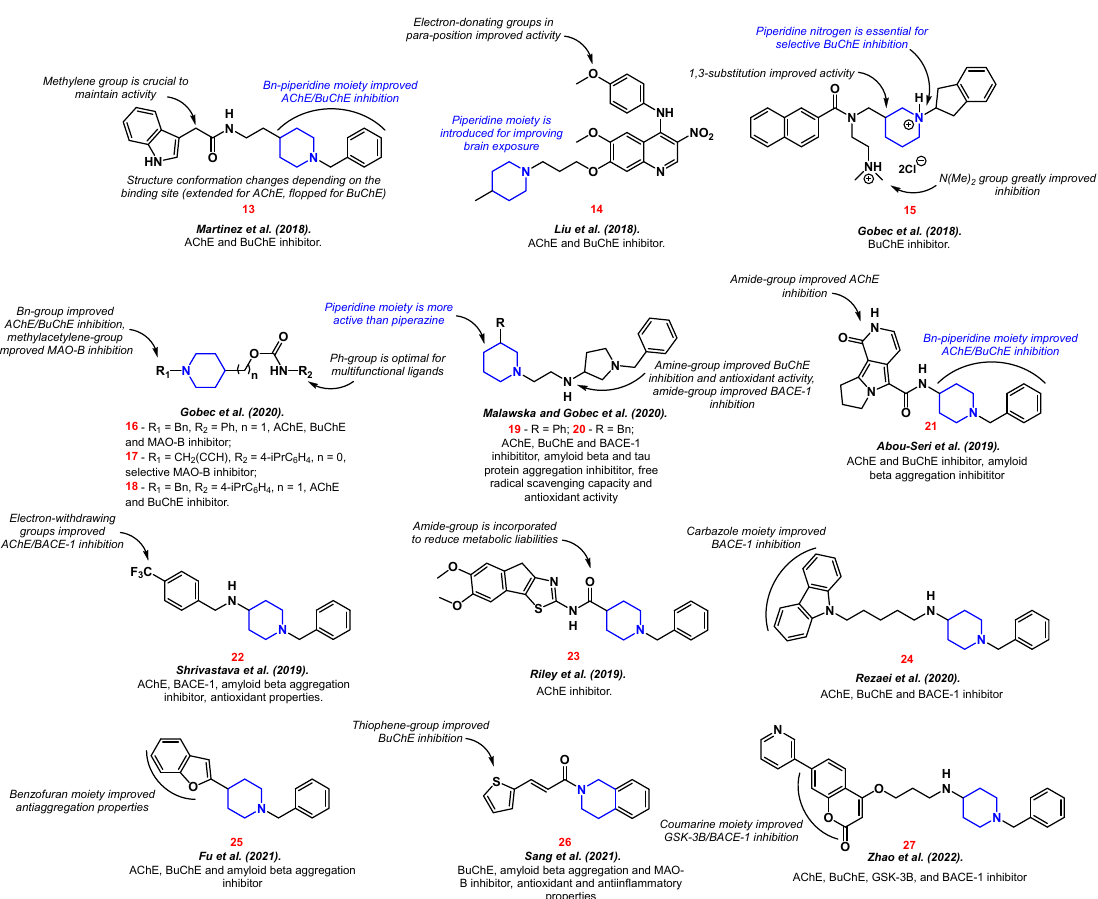
Figure 6. Piperidine derivatives as potential drugs for Alzheimer disease therapy [242–247,252–258].